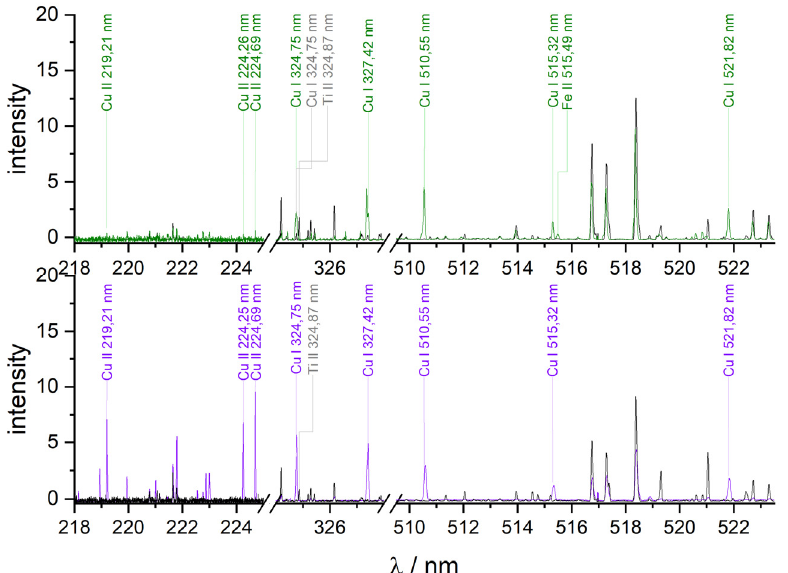
Figure 2. LIBS spectra of the field sample compared with the corresponding host rock. ( Top ): Field sample from Cyprus compared with basalt. ( Bottom ): Field sample from Poland compared with schist. Eight copper lines are identified in each of the field sample spectra. Lines in the rock spectra that are in the spectral vicinity of the copper lines are marked in grey. The measurements were performed with the Echelle spectrometer.